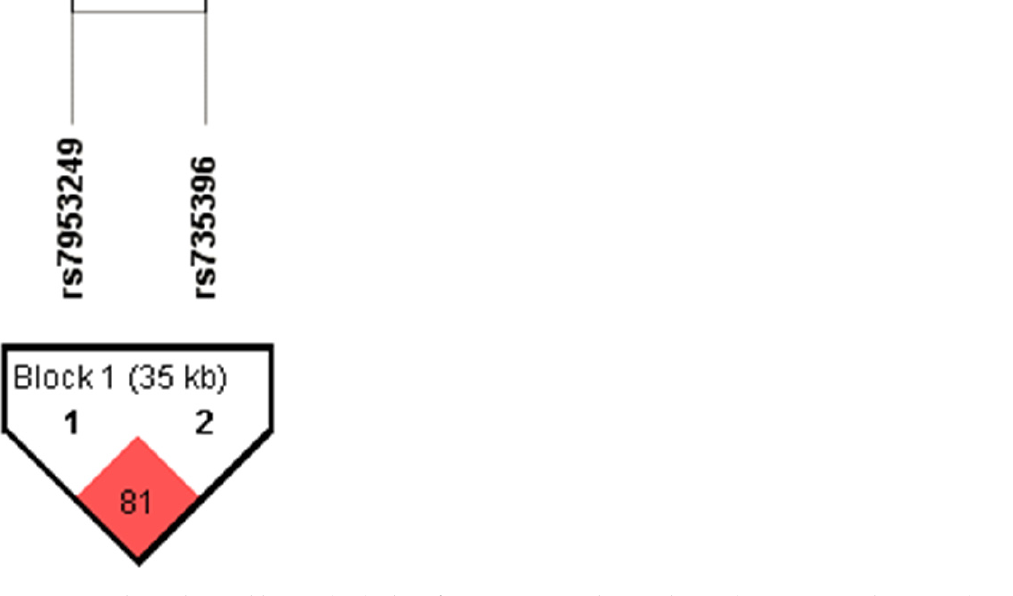
Figure 1. Linkage disequilibrium (LD) plot of two HNF1A polymorphisms (rs7953249 and rs735396). Pairwise LD value (D’ × 100) calculated for this SNP combination (LD = 81 as denoted in a red rectangle) indicates a strong link between rs7953249 and rs735396 polymorphisms.